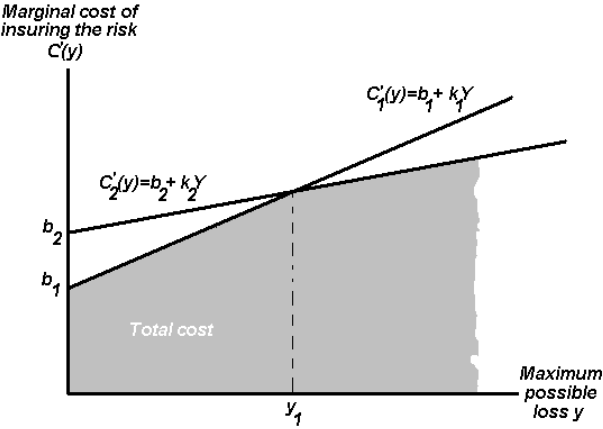
Fig. 1. Cost-minimizing contract with 1 entity. Fig. 2. Cost-minimizing contract with 2